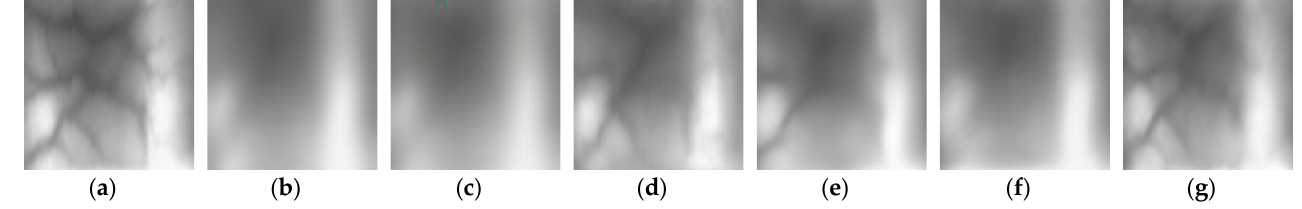
Figure 25. Examples of restored PolyU-DB finger-vein images using state-of-the-art methods and the proposed RMOBF-Net (motion blur with Gaussian blur filter of 15 × 15): ( a ) original image, ( b ) blurred image, and restored images by ( c ) DeblurGAN, ( d ) DeblurGANv2, ( e ) SRN-DeblurNet, ( f ) MPRNet, and ( g ) RMOBF-Net.